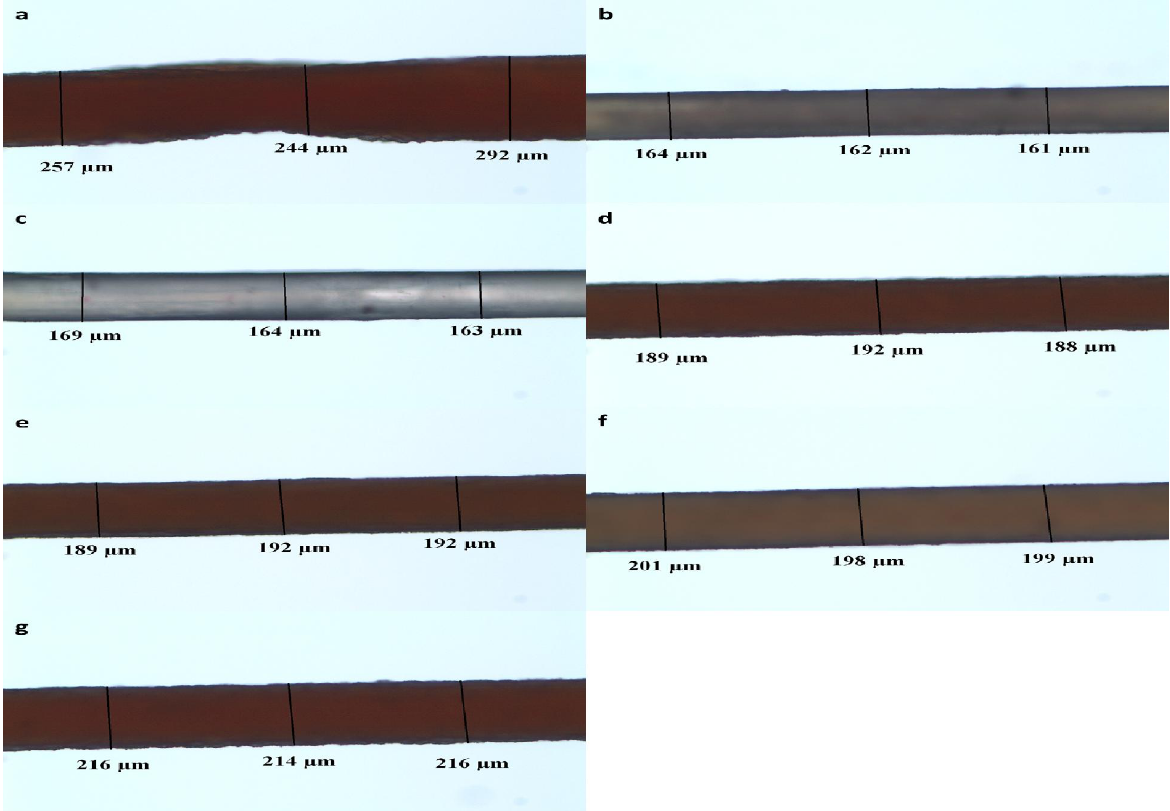
Figure 7. Light micrographs of dried fibers spun at different spinning rates: ( a ) 0.17 mL/min; ( b ) 0.25 mL/min; ( c ) 0.33 mL/min; ( d ) 0.5 mL/min; ( e ) 0.67 mL/min; ( f ) 1 mL/min; and ( g ) 1.33